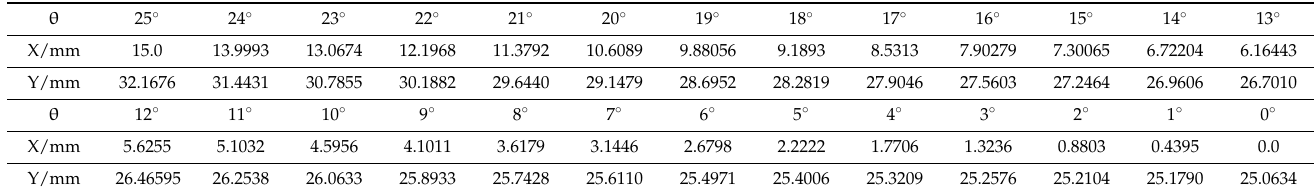
Table 2. Center aspheric discrete points.